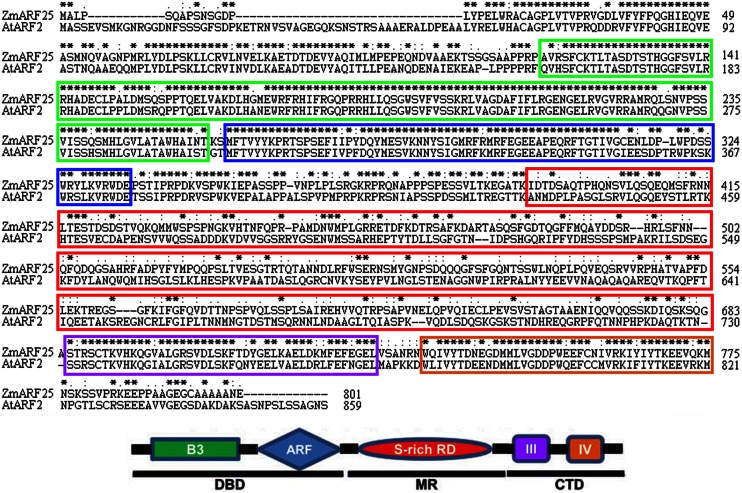
Amino acid sequences alignment and graphical representation for domain organization of ZmARF25 proteins.Identical amino acids are indicated by asterisks, amino acid position numbers are indicated on the right. B3 domain is marked with green box, ARF subdomain is marked with blue box, MR is marked with red box, and subdomain III and IV are marked with purple box and orange box, respectively.